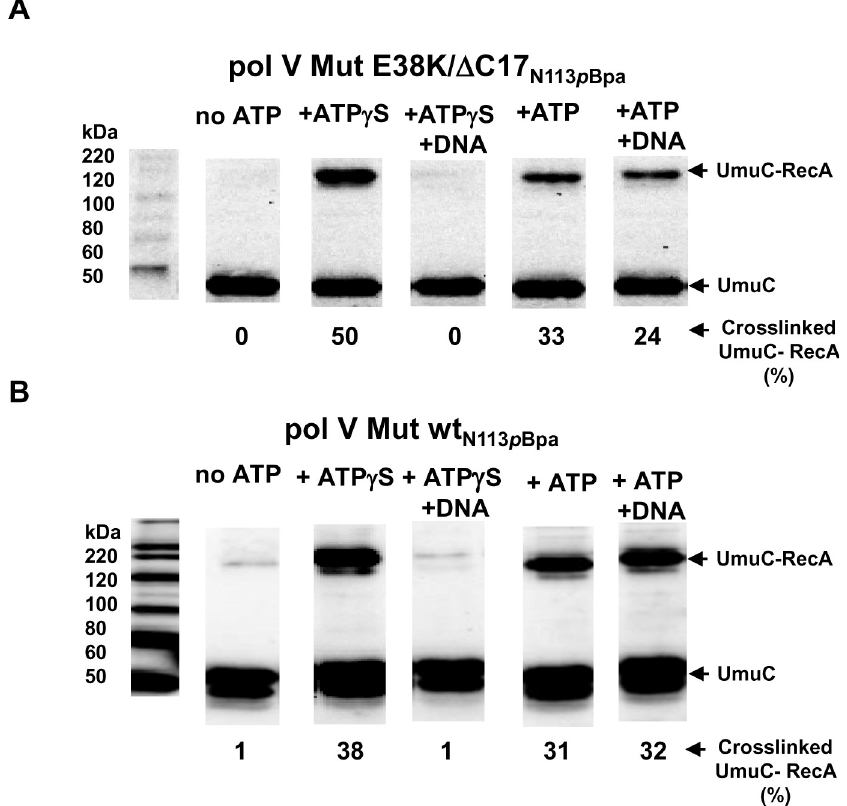
Fig 6. ATP and DNA induced conformational changes of pol V Mut. Crosslinking and western blot analysis using anti-UmuC antibody demonstrate conformational changes within pol V Mut E38K/ Δ C17 (A) and pol V Mut wt (B) that result from binding first to ATP γ S/ATP (500 μ M), and then to p/t DNA DNA (5 μ M) in the presence of ATP γ S/ATP. Pol V Mut was assembled with crosslinkable (A) RecA E38K/ Δ C17 N113 Crosslinking experiments were repeated 4 times and the % of the UmuC-RecA crosslinking is shown below each Western blot and in S7 Fig.